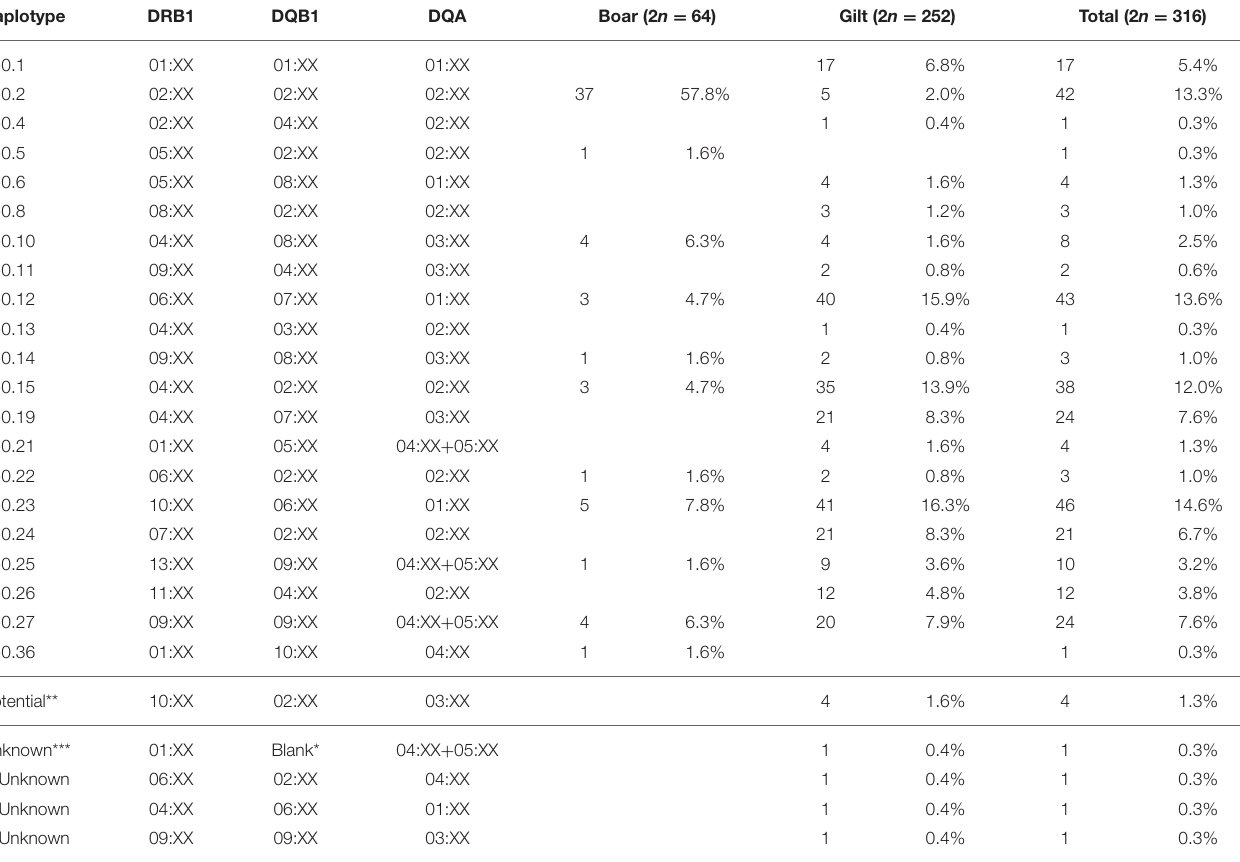
TABLE 4 | Frequency of SLA class II haplotypes.